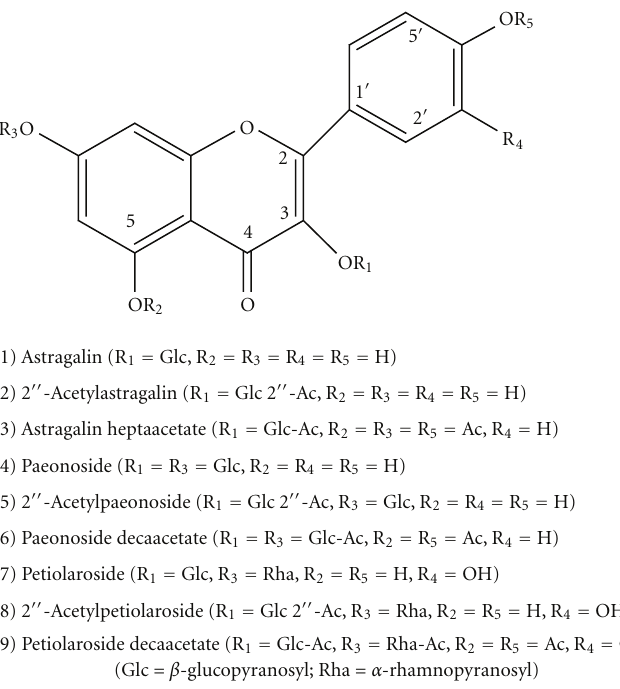
Figure 1: Flavonoid compounds